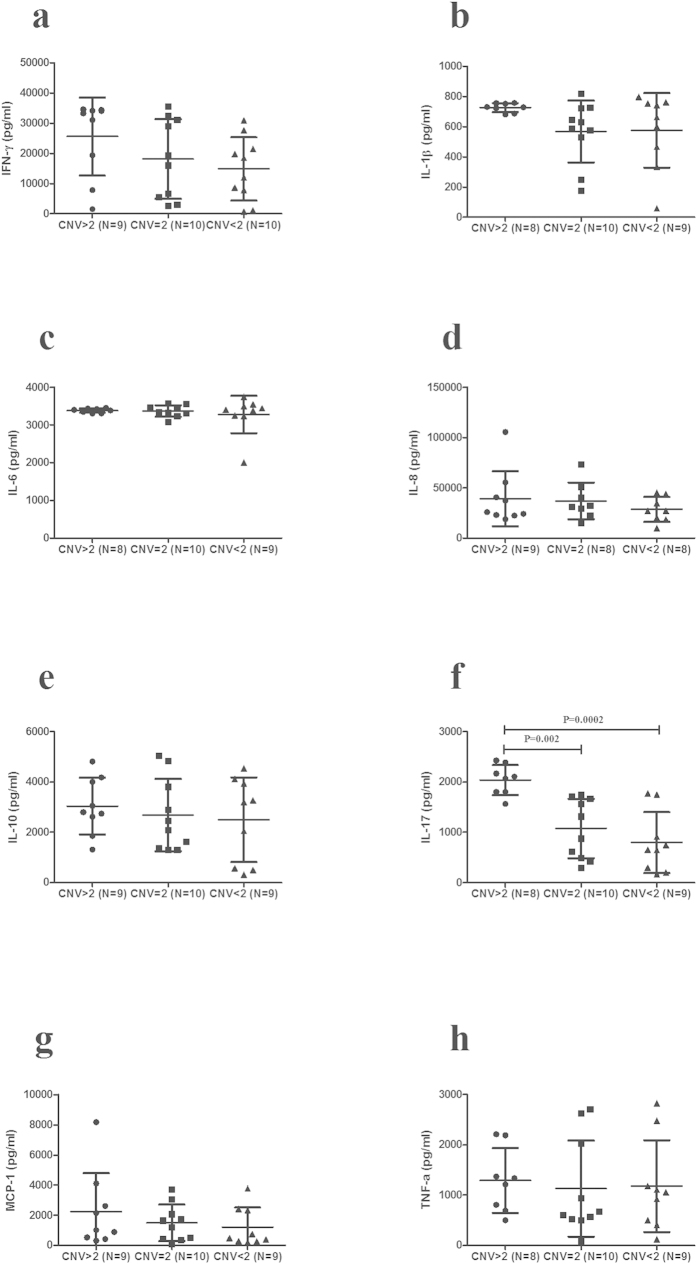
The influence of C5 CNVs on cytokines production.Different copy numbers of C5 on cytokines production. The levels of IFN-γ (a), IL-1β (b), IL-6 (c), IL-8 (d), IL-10 (e), IL-17 (f), MCP-1 (g), and TNF-α (h) in PBMCs from normal controls with different copy numbers (CNV > 2: n = 8–9, CNV = 2: n = 8–10, CNV < 2: n = 8–10). Significance was tested by two independent samples Nonparametric test or one-way ANOVA test.